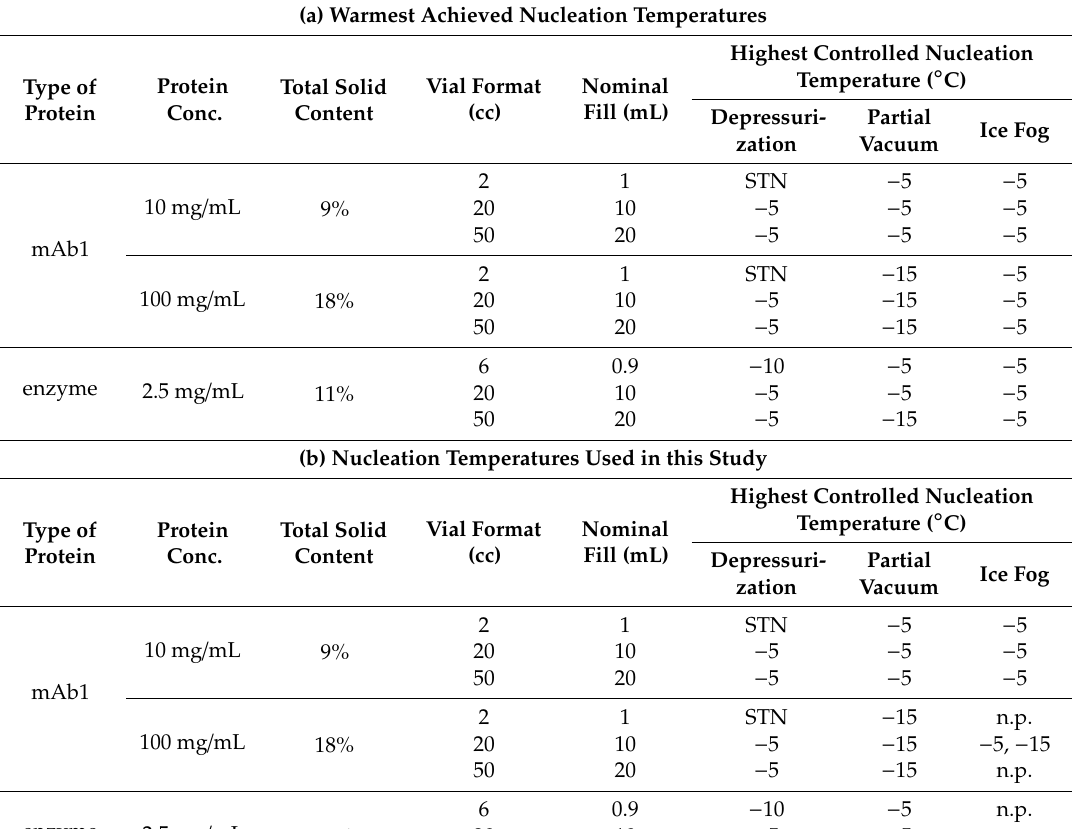
Table 2. Nucleation temperatures. STN = stochastically nucleated (failed to nucleate), n.p. = not